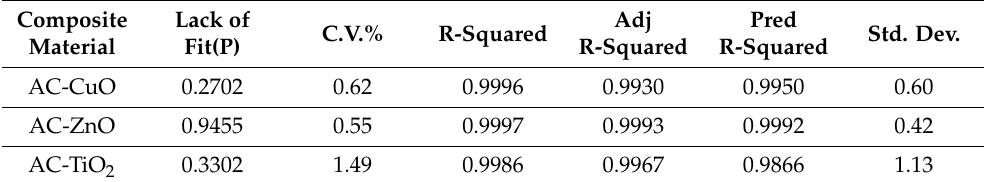
Table 3. Significance analysis results of the response surface regression model of the methylene blue removal